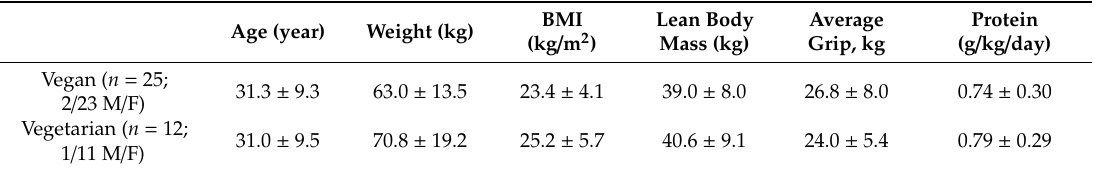
Table 1. Participant characteristics *.